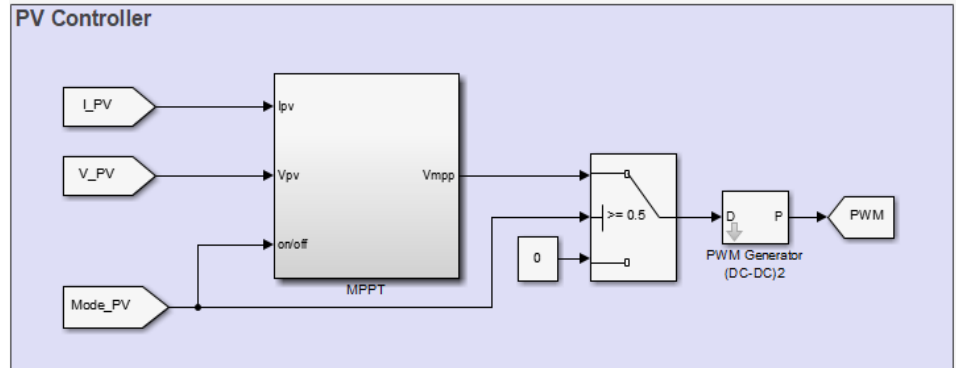
Figure A5. Control block diagram of the PV.